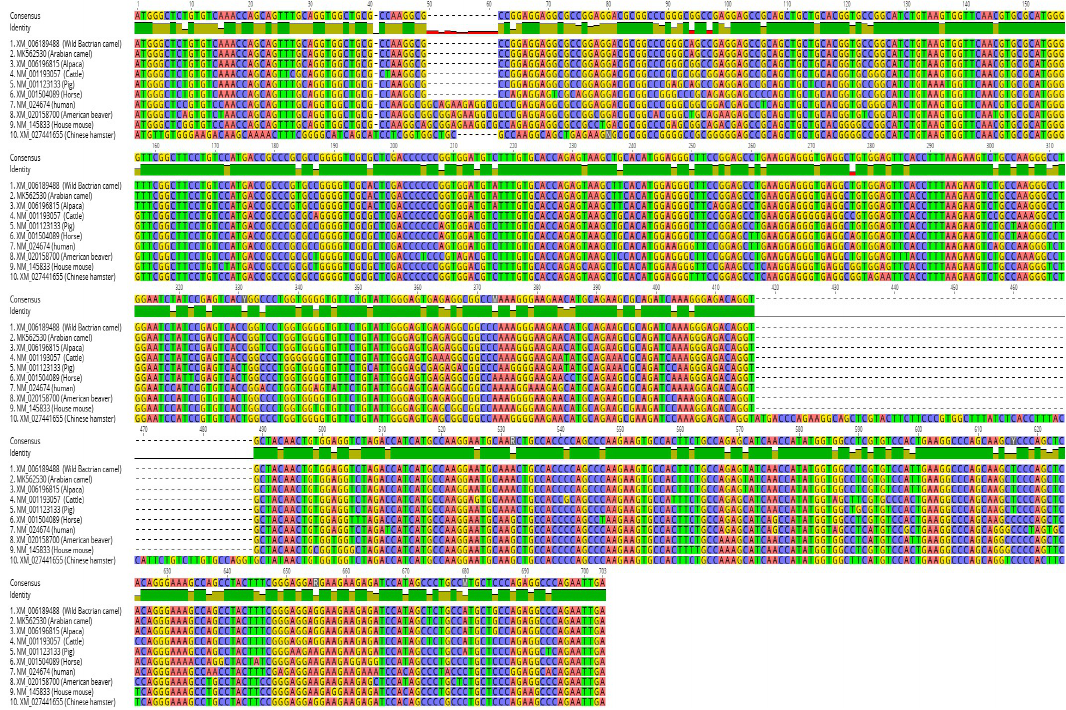
Figure 4. Multiple alignment of the nucleotide sequence of cLin-28 mRNA with nine other mammalian species. Identical nucleotides are marked in